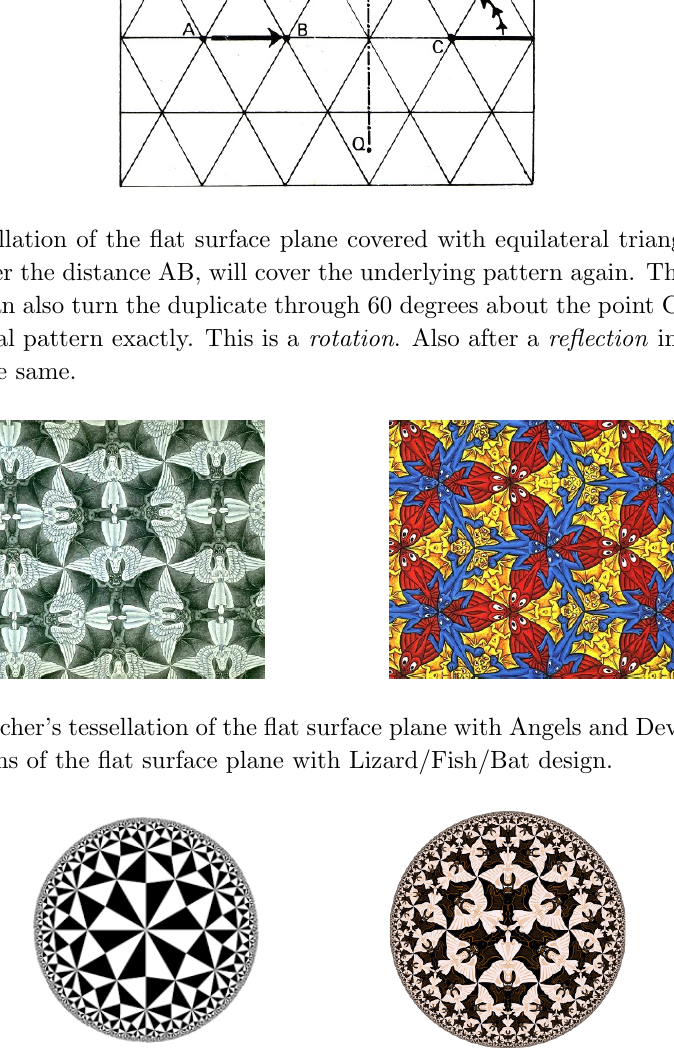
Figure 3 . Left: Coxeter’s tessellation of a hyperbolic plane by triangles (Poincar(cid:19)e disk model). Right: Escher’s tessellation for the hyperbolic tiling for the woodcut Angels and Devils, \Circle Limit